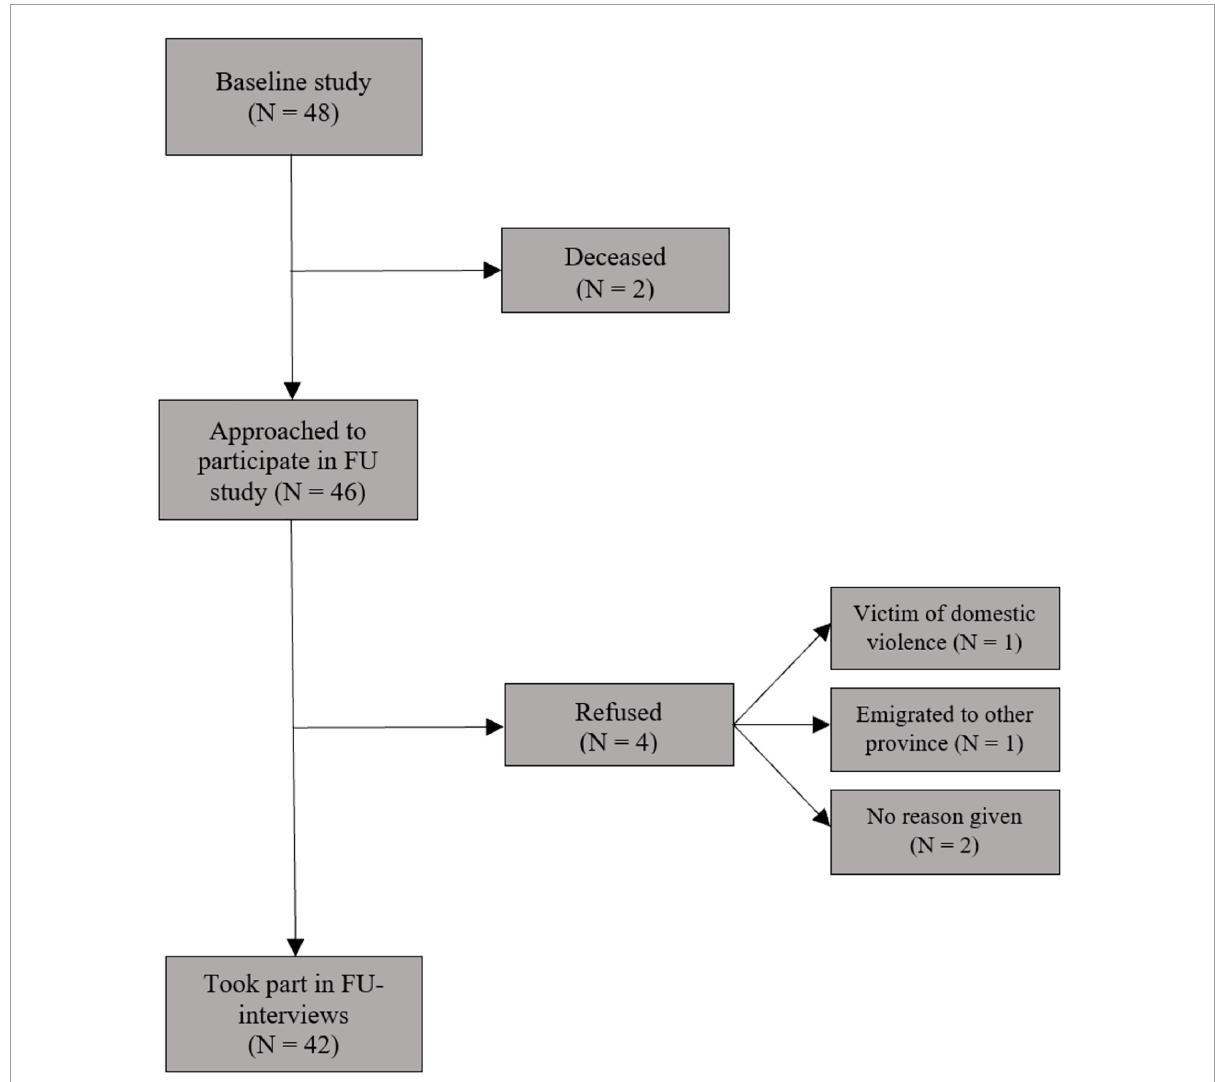
FIGURE1 Flowchart for re-recruiting individuals from baseline study into follow-up